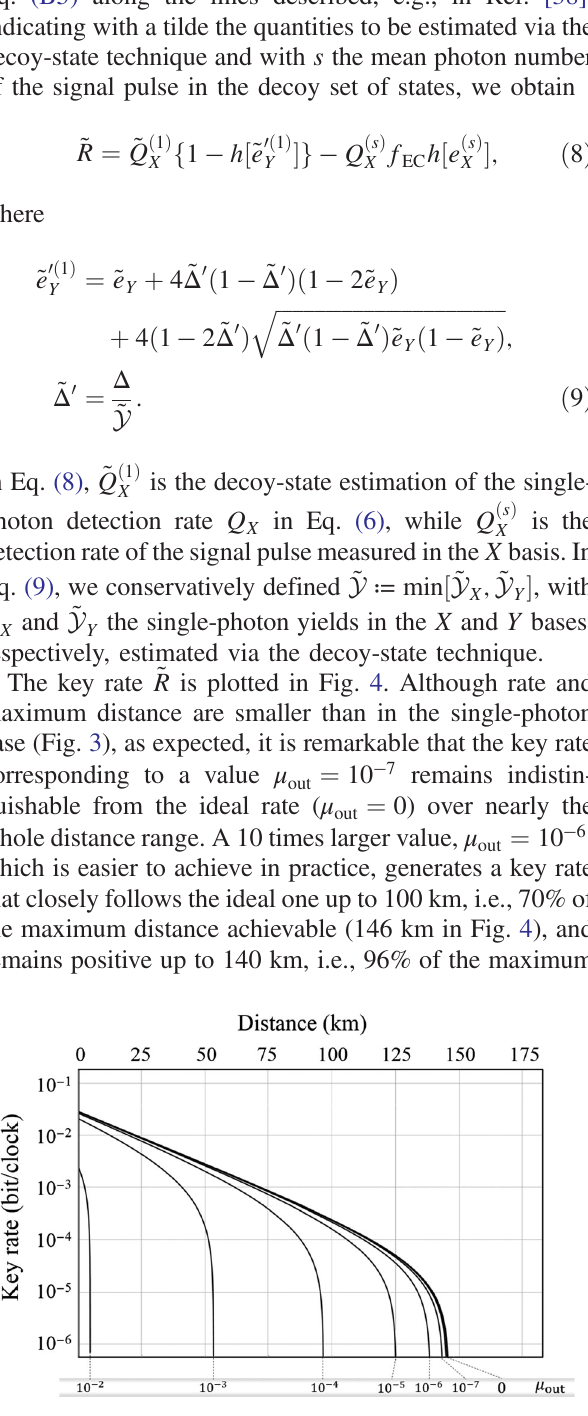
~ R FIG. 4. Asymptotic key rate versus distance for the decoy- state efficient BB84 protocol under a THA, for various values of the output mean photon number μ . Experimental parameters in out the simulation are as in Fig. 3. The average photon number of the signal states in the decoy-state technique is s ¼ 0 . 5